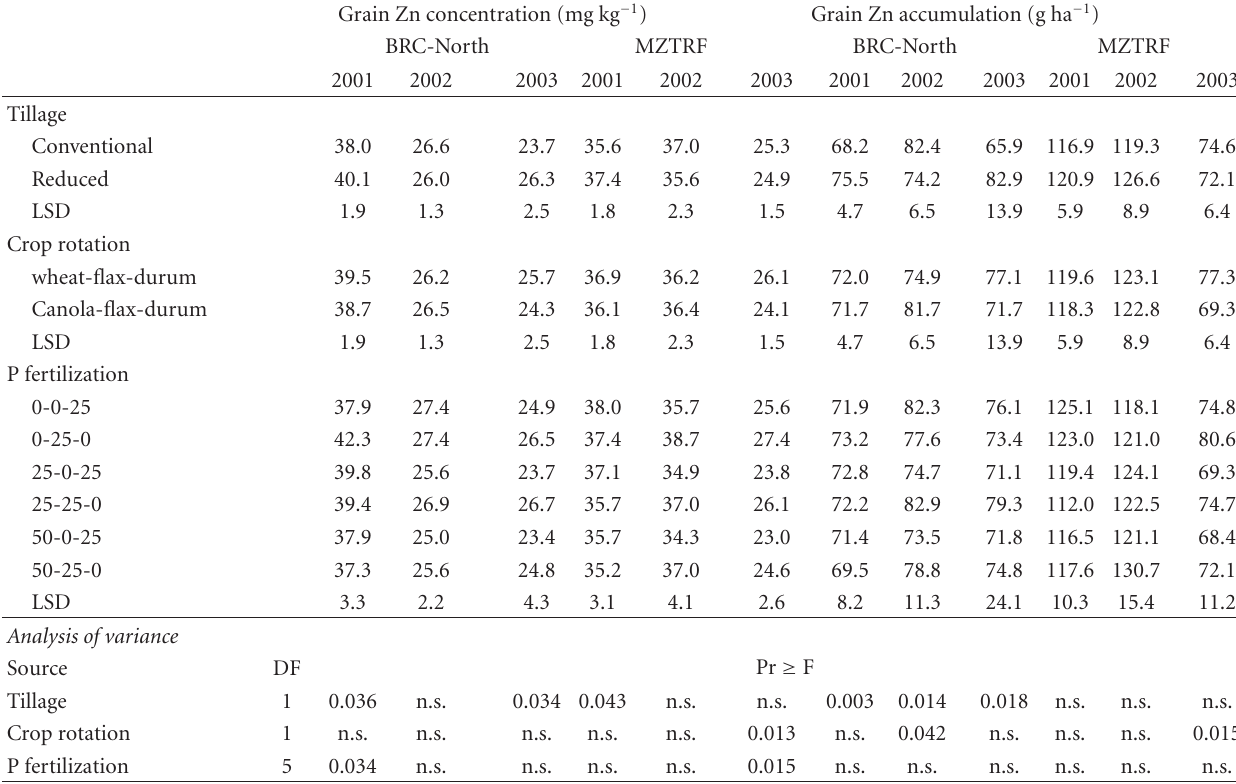
Table 5: Grain Zn concentration (mg kg − 1 ) and accumulation (g ha − 1 ) of durum wheat as a ff ected by tillage system, crop rotation, and P fertilization on at two sites over 3